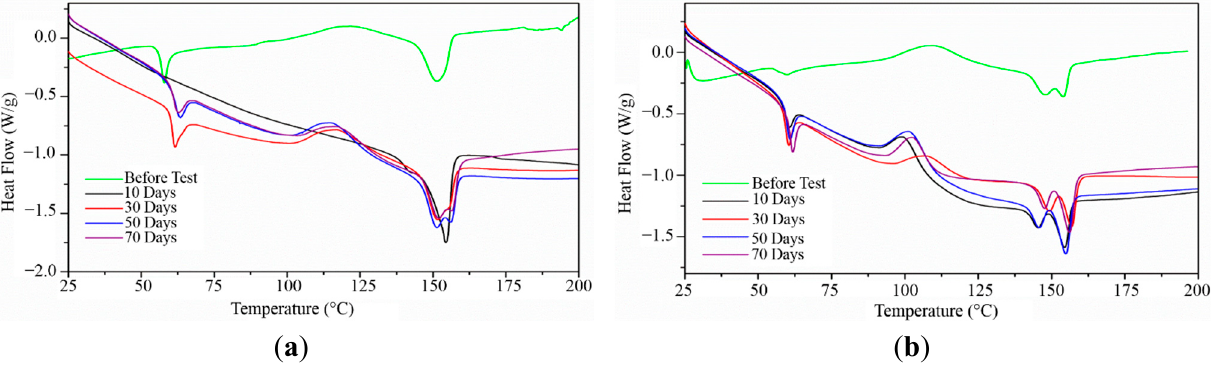
Figure 7. DSC thermograms of virgin PLA ( a ) and BF-PLA ( b ) composites in real composting condition. Table 4. DSC numerical data of BF-PLA composites after biodegradation in real composting conditions. Samples